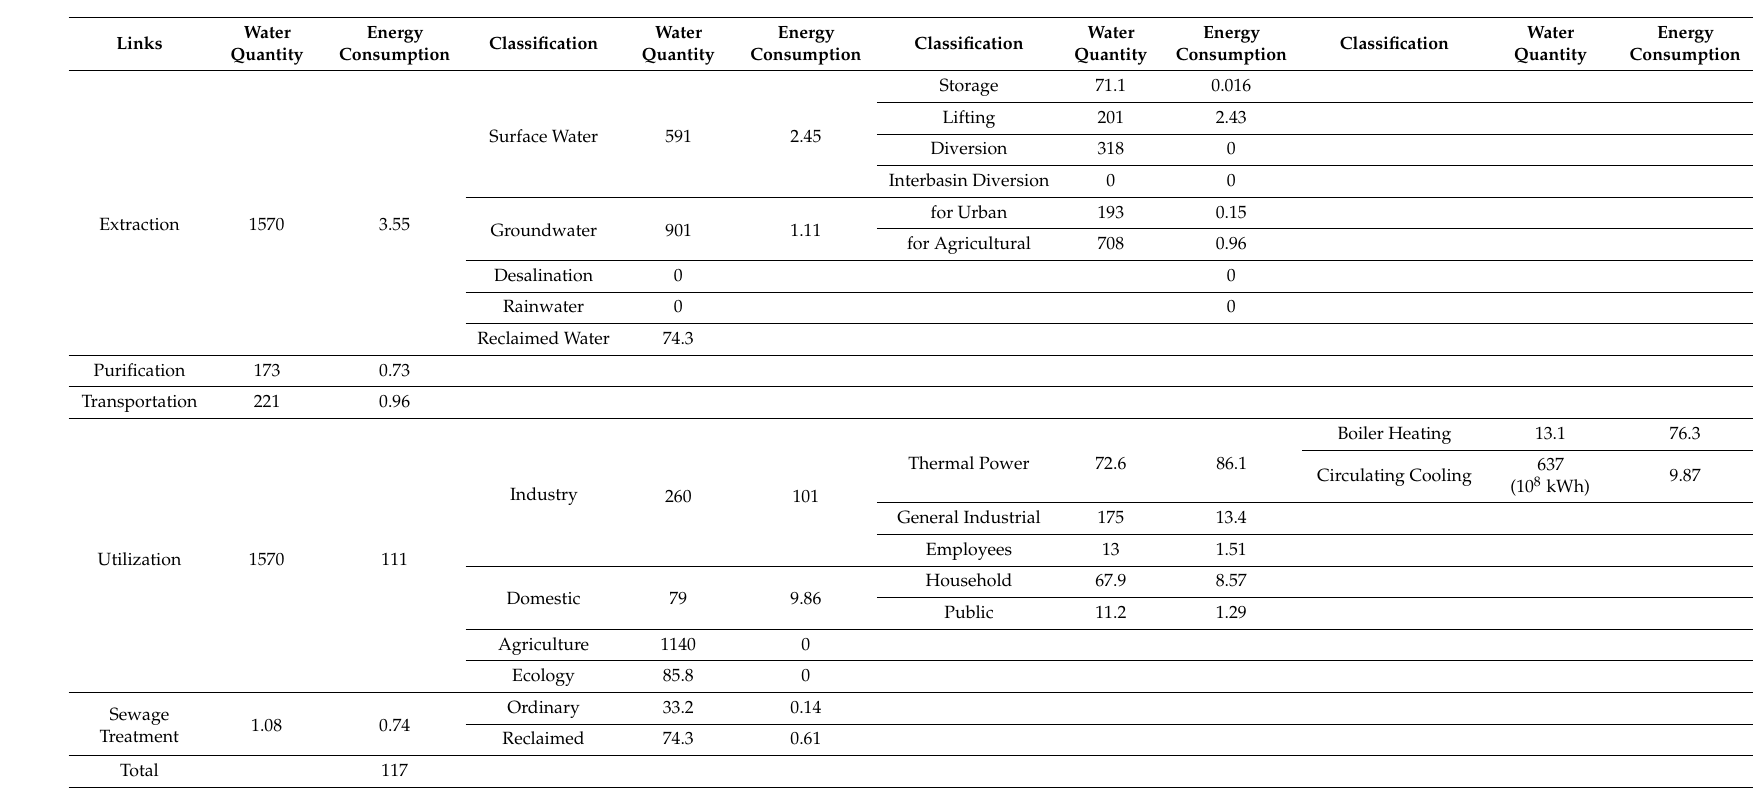
Table A4. Energy consumed through the use of water in Ordos, China, for